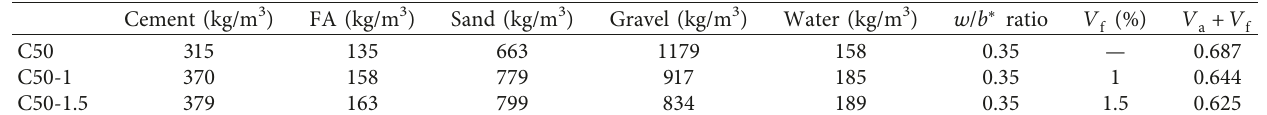
Table 1: Mixture proportions.